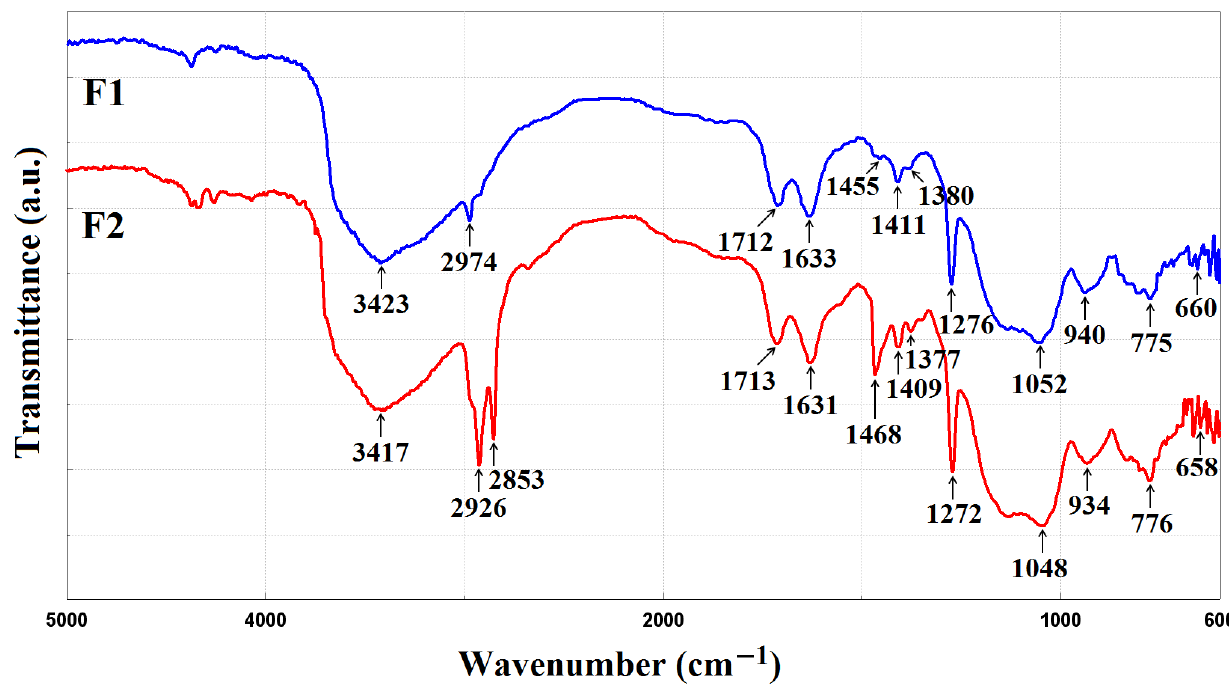
Figure 2. FTIR spectra of fluorinated silica materials (as powders): TEOS/MTES/FS (F1) and TEOS/MTES/HDTMES/FS (F2).